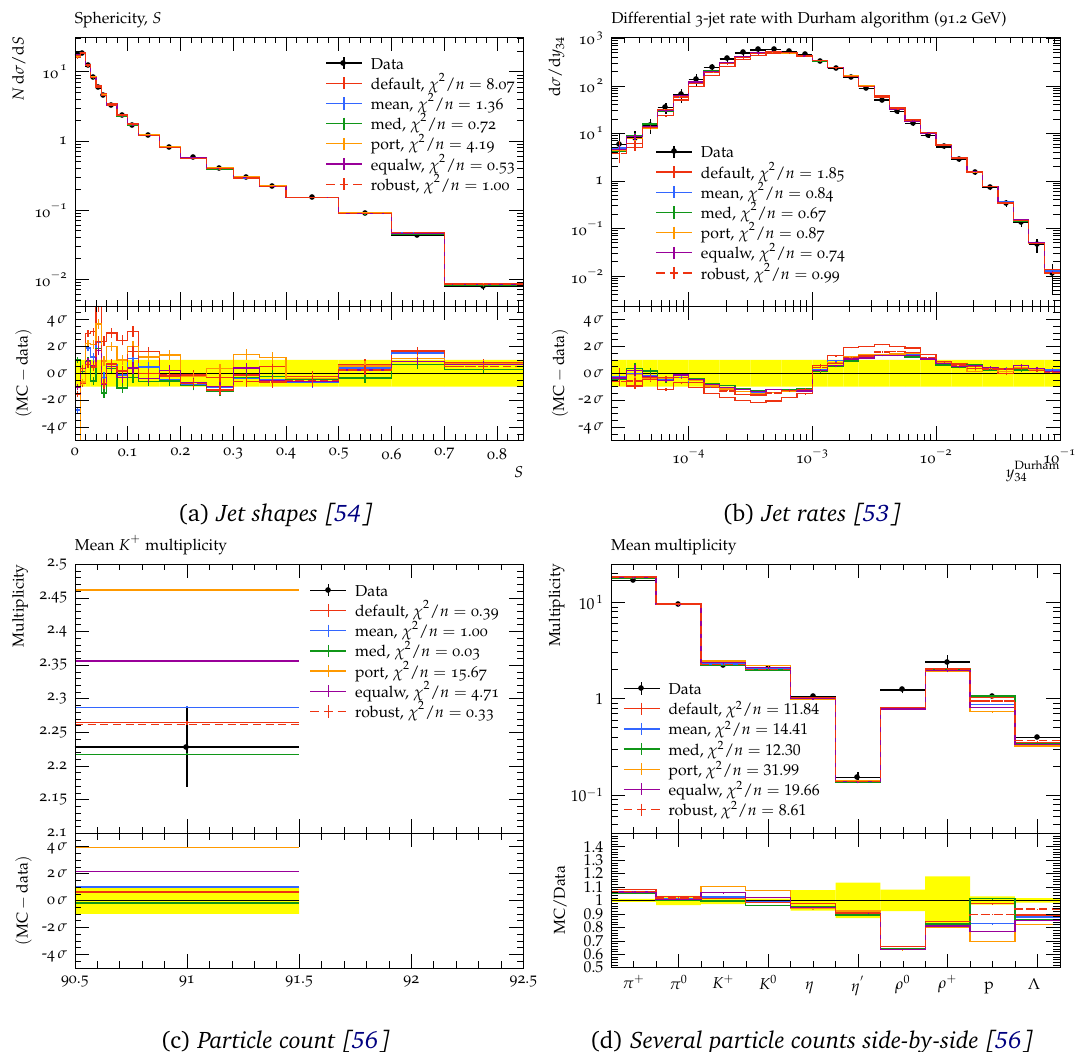
Figure 10: Examples of histogram plots of the χ 2